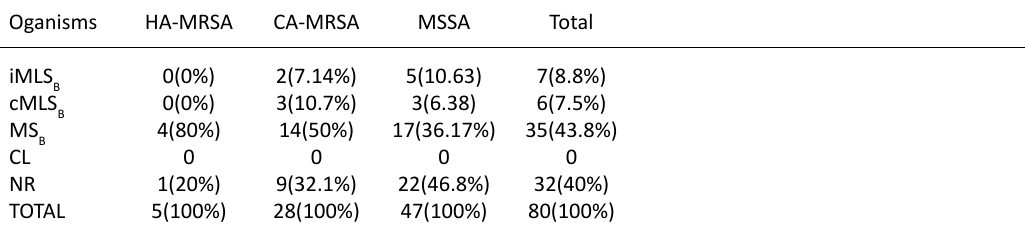
phenotypes in MRSA and MSSA B